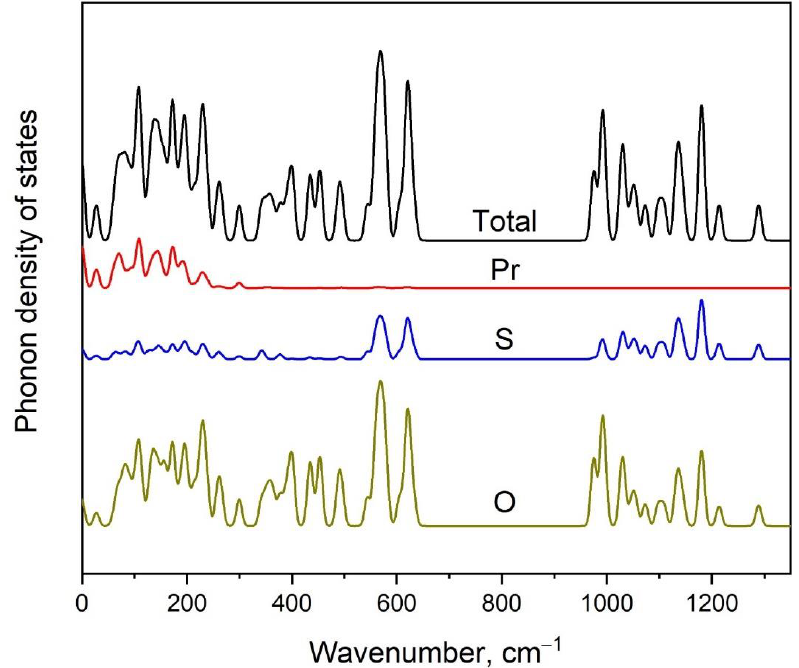
Molecules 2022 , 27 , x FOR PEER REVIEW Figure 8. Calculated phonon density of states in Pr 2 (SO 4 ) 3 . Figure 8. Calculated phonon density of states in Pr